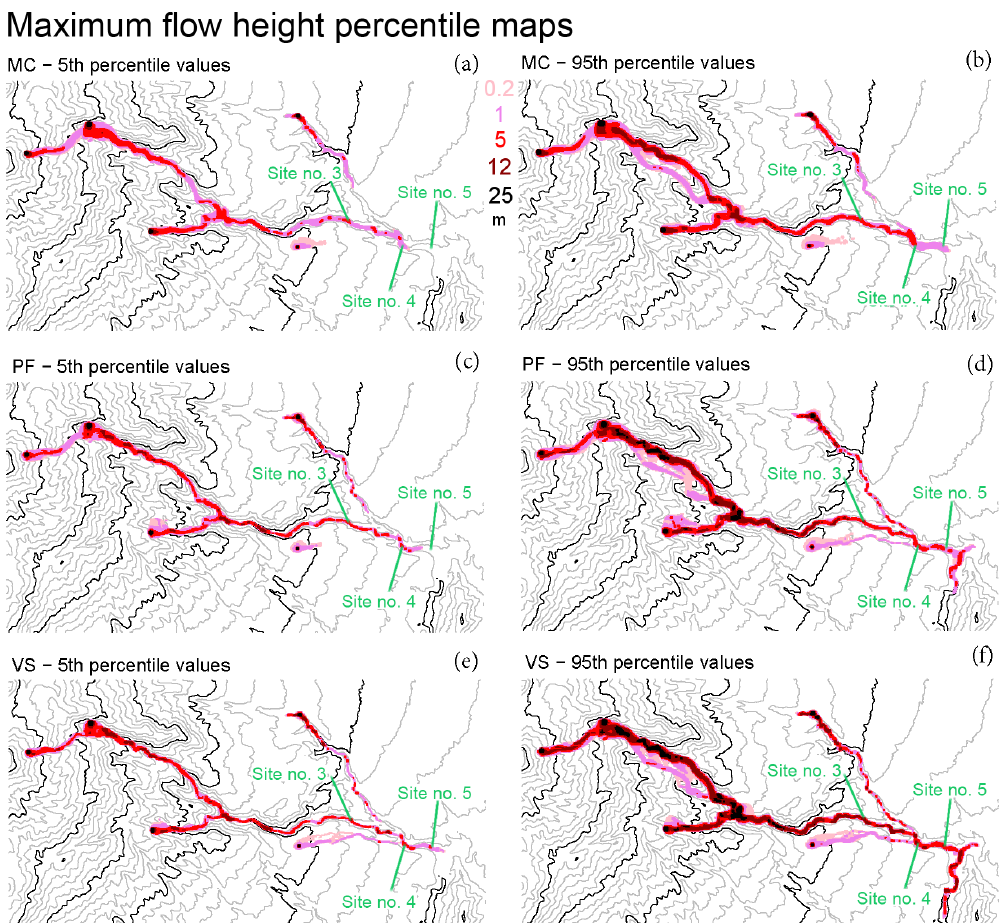
Figure 7. Maximum flow height H as a function of time in (a, b) MC, (c, d) PF, and (e, f) VS models. Panels (a, c, e) are the 5th and (b, d, f) are the 95th percentile values with respect to P j . Colors are related to the flow height. Elevation contours are included at intervals of 100m (gray) and 500m (black) (NASA – JPL, 2014). Sites 3–5 are